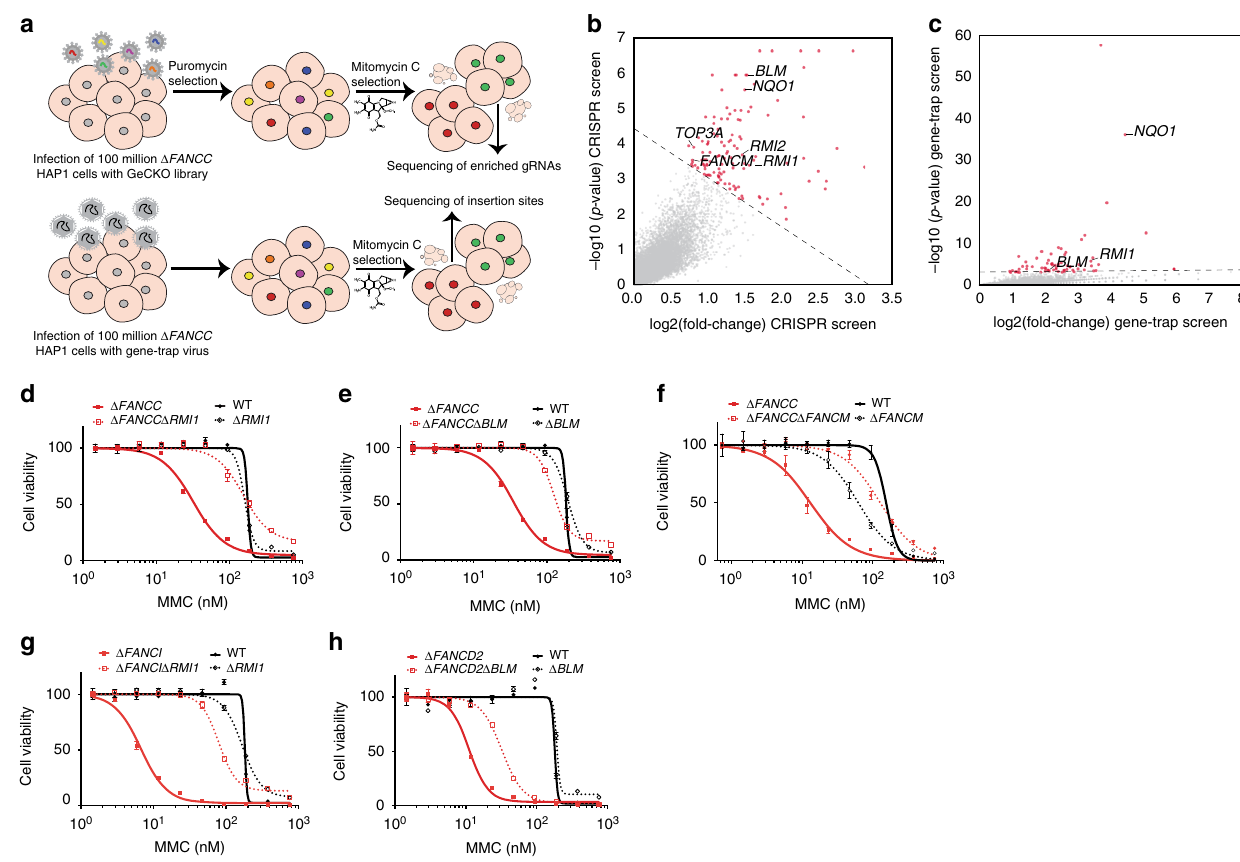
Fig. 1 Genome-wide CRISPR-Cas9 and insertional mutagenesis screens identify the BLM complex as a synthetic viable interaction for FANCC. a Work fl ow for the identi fi cation of genetic synthetic viable interactions for Δ FANCC cells following MMC exposure by two parallel genome-wide approaches: CRISPR- Cas9 and insertional mutagenesis. b Viability-inducing genes identi fi ed using a genome scale CRISPR knock-out (GeCKO) library in Δ FANCC cells treated with MMC, compared to untreated WT cells are shown in red, and include members of the BLM complex, FANCM and NQO1 . Each dot represents the average score of the six guide RNAs (gRNAs) per gene. c Viability-inducing genes identi fi ed using gene-trap insertional mutagenesis in Δ FANCC cells treated with MMC, compared to untreated WT cells. Members of the BLM complex and NQO1 are labeled. For robust identi fi cation of enriched genes in b , c , hit selection was performed in two steps. First, each data set was partitioned into two groups, de fi ning the hit-group as data points with p < 0.001 and fold-change > 2 1.5 . In a second step, hit selection was optimized using linear discriminant function analysis. d – h Indicated cell lines were exposed to MMC for 4 days and cellular survival was assessed by CellTiter-Glo. Means and S.E.M. of biological triplicates are